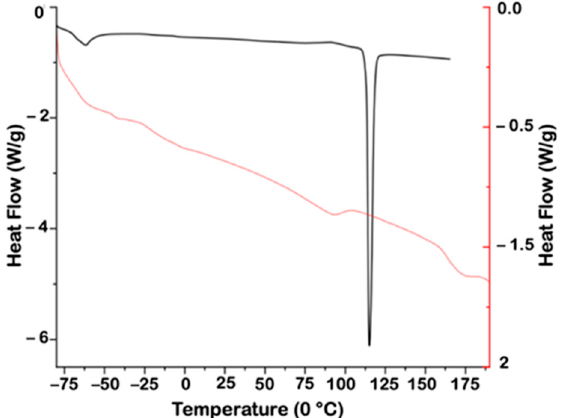
Figure 2. Differential scanning calorimetry (DSC) profiles of 2 (black trace) and 2a (red trace), respectively.